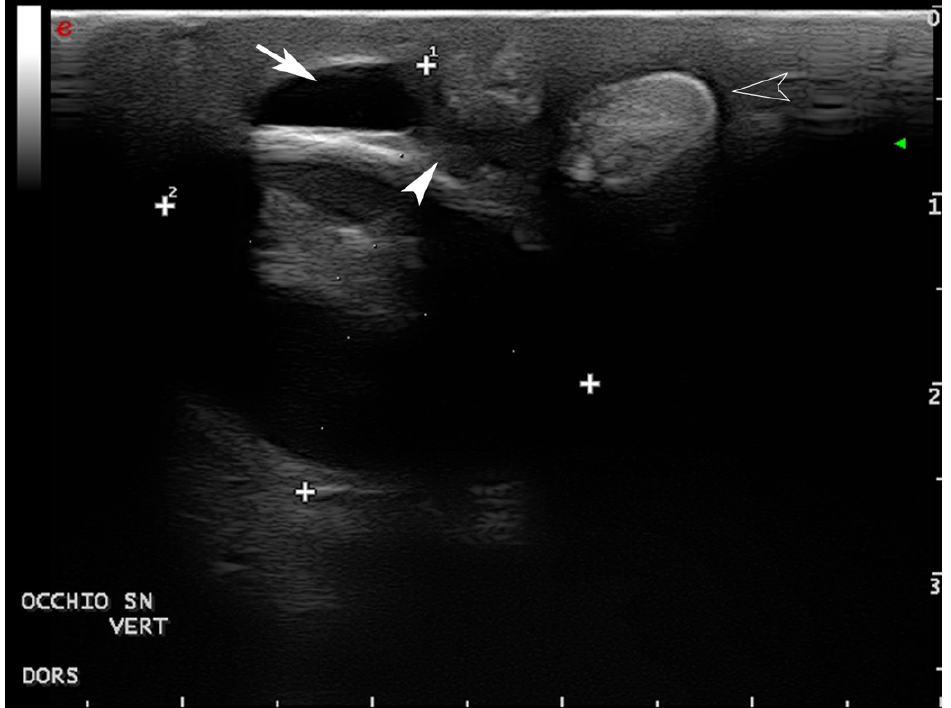
Figure 4. Ultrasonography of the left eye, vertical lateral-parasagittal scan: a fluid collection in the dorsal conjunctival space is present (arrow) delimitated ventrally from adhesion between the eyelid and cornea (arrowhead). More ventrally, a salt dacryolith is visible at the gland level (empty arrowhead). (Plus are electronic calipers to evaluate the eye depth 1 and height 2